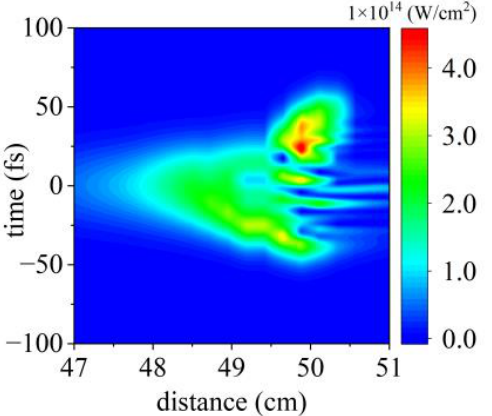
Figure 5. The on-axis laser intensity as a function of the propagation distance for a 40 fs, 3.4 mJ pulse. The gas pressure is 200 mbar.